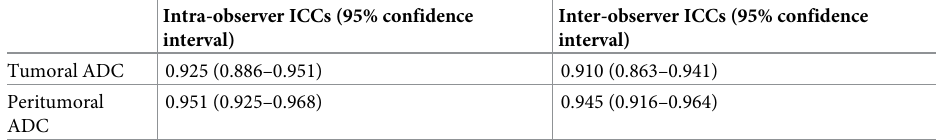
Table 3. Interclass Correlation Coefficients (ICCs) of